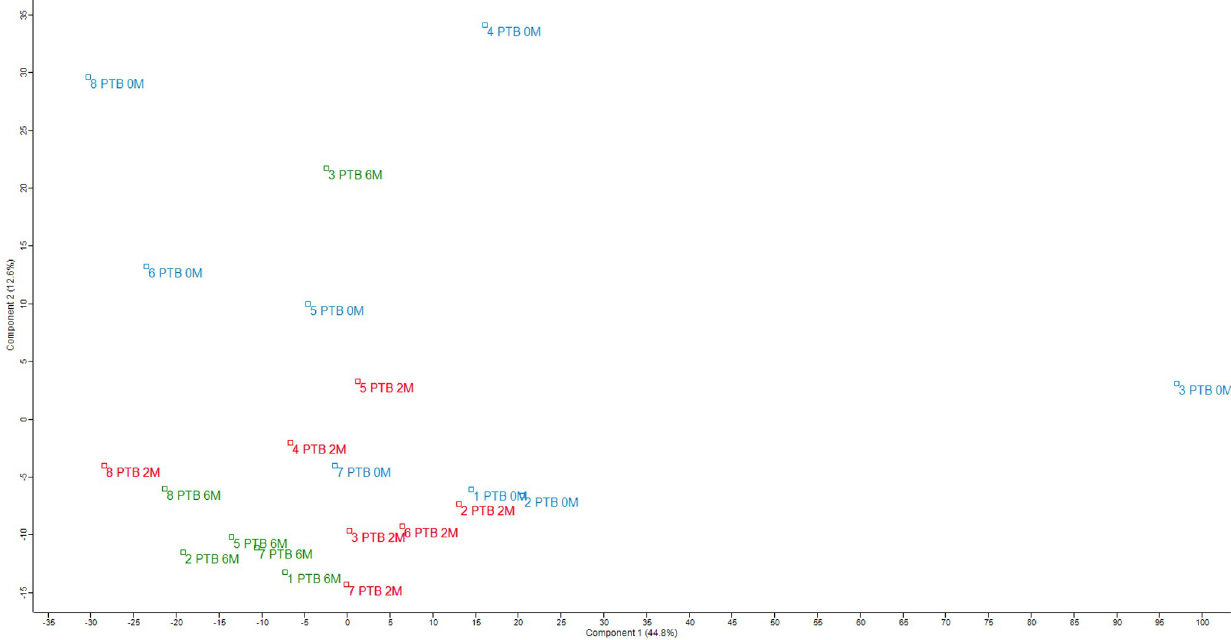
Fig 2. Principal component analysis of all samples. A PCA analysis were performed on all samples in Perseus using Benjamini-Hochberg FDR